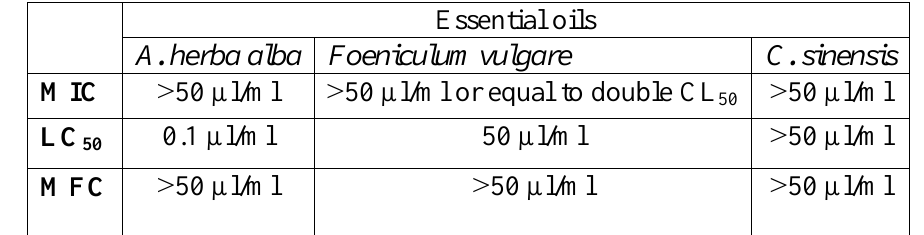
Table 6. Comparison of the Minimum inhibitory concentration (MIC), legal (LC50) and minimum fungicidal concentrations (MFC) of essential oils against fungal